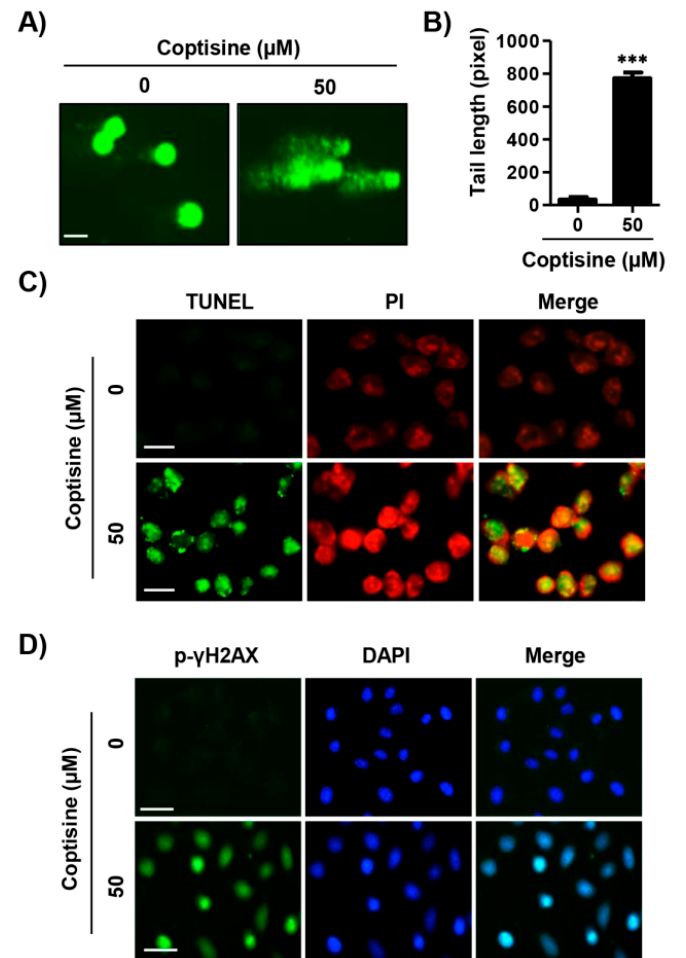
Figure 2. Induction of DNA damage by coptisine in Hep3B cells. Hep3B cells were treated with 50 µM coptisine for 24 h. ( A ) The comet assay was performed, and representative images of comet assay were taken by fluorescence microscopy. Scale bars, 50 µm; ( B ) Statistical analysis of tail length. *** p < 0.001 vs. control; ( C ) DNA break of apoptotic cells was assessed by terminal deoxynucleotidyl transferase-mediated dUTP-biotin nick end labeling (TUNEL) assay and images were obtained by fluorescence microscopy. Green staining (left) indicates apoptotic cells, and propidium iodide (PI) staining was used to visualize nuclei (middle). Scale bars, 20 µm; ( D ) The expression of phospho-H2A histone family member X ( p- γ H2AX ) was investigated with immunofluorescence. Green staining (left) indicates p- γ H2AX-positive cells and 4 ′ ,6-diamidino-2-phenylindole (DAPI) staining was used to visualize nuclei (middle). Merged image indicates the localization of p- γ H2AX-positive cells in nuclei (right). Scale bars, 30 µm.